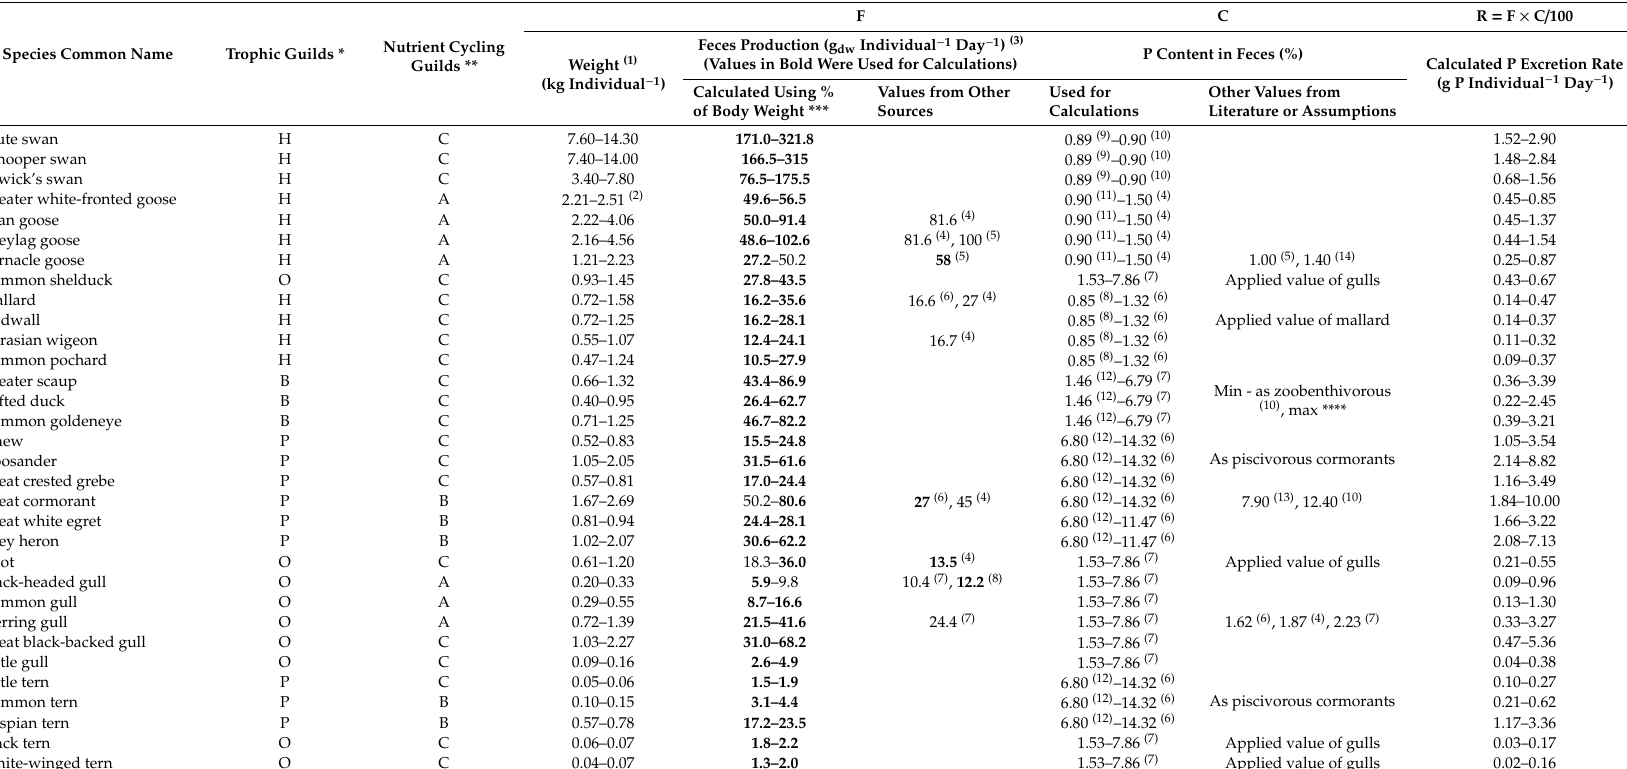
Table 2. Trophic and nutrient cycling guilds of waterbirds, species weight, feces production, P content, and calculated P excretion rates. In column F, only the values in bold were used for calculations, combining extreme rates of feces production from both calculated values and values from other sources; this was done in order to have the widest possible range of feces production and potential P excretion, including true